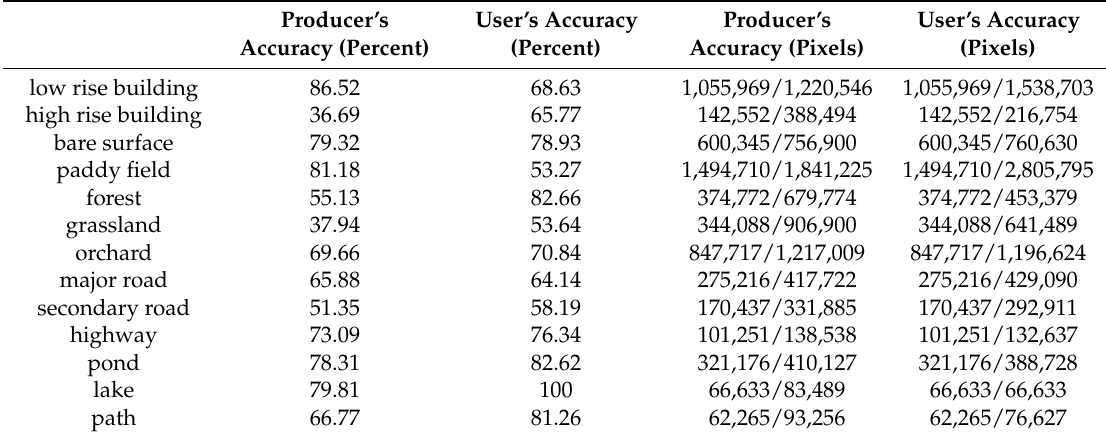
Table 1. Accuracy assessment of land cover extraction.